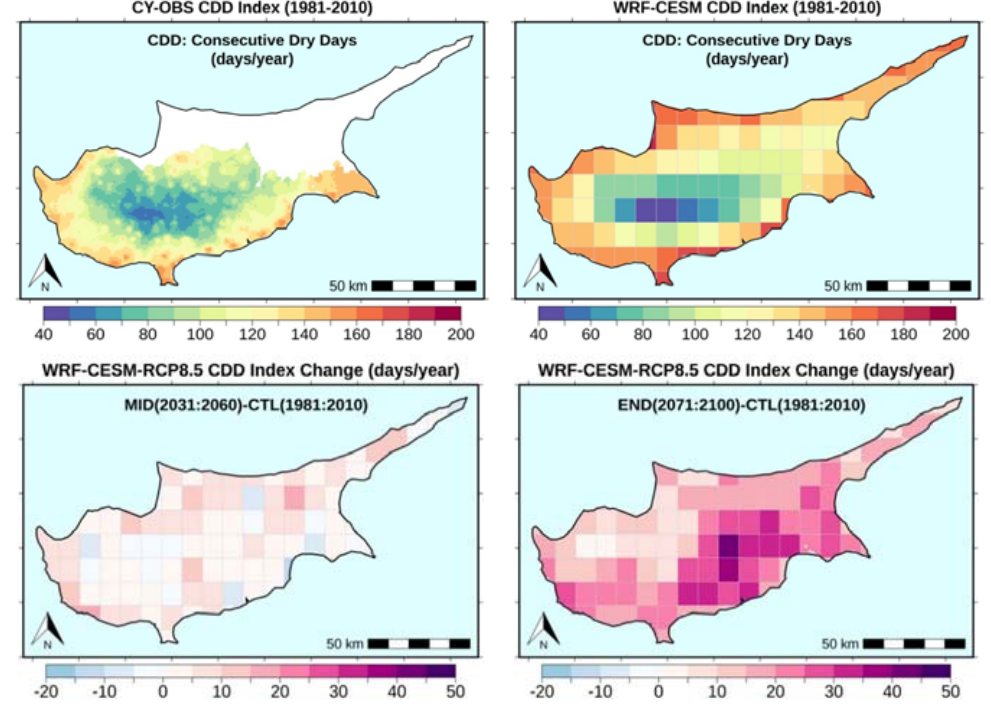
Figure 6. Observed ( top left ) and simulated ( top right ) maximum number of consecutive dry days per year (CDD) for the period 1981 to 2010 and projected changes for the middle ( bottom left ) and end of the 21st century ( bottom right ).